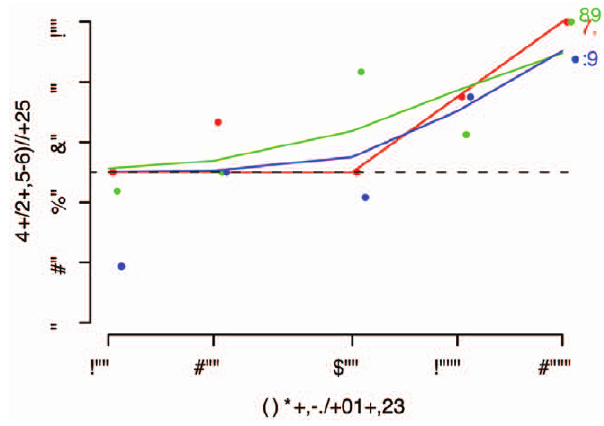
Figure 3. Percent correct performance on a set of 2 AFC test trials administered three years after training. Dots show individual participants’ performance in one frequency range and are jittered slightly on the horizontal to avoid overplotting. Lines show best fitting half-logit regression models for individual participants.